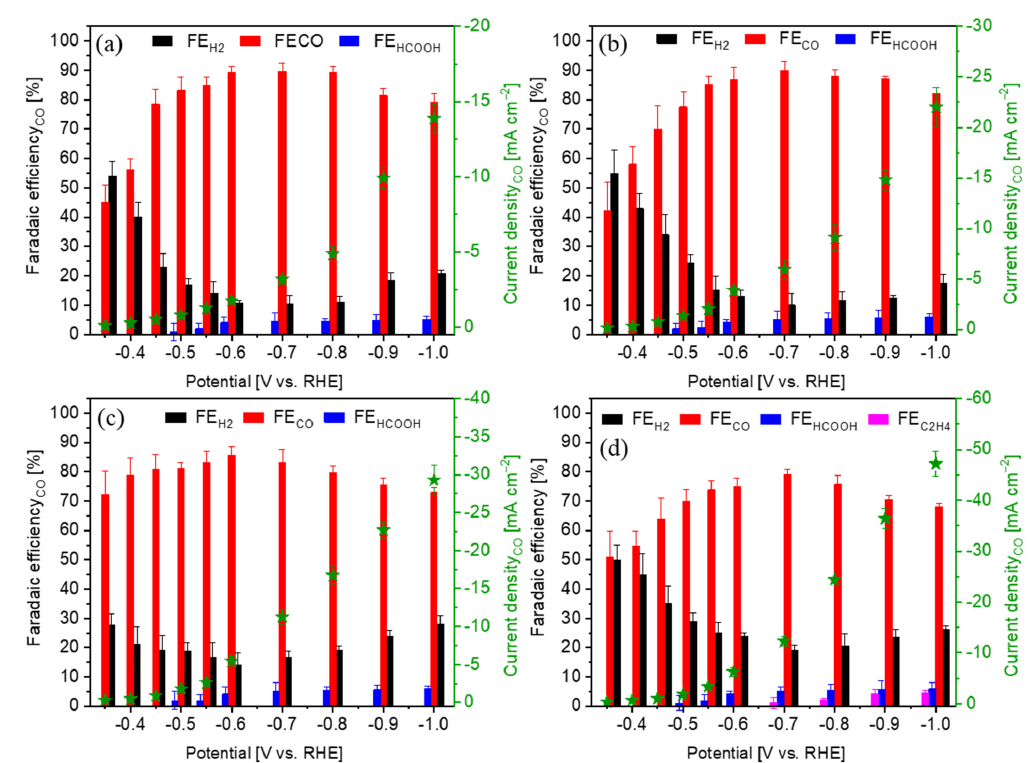
Figure 5. Product analyses and CO current density at a Sn-Cu 2 O electrode in a semi-flow cell with various CO 2 -saturated KHCO 3 electrolytes: ( a ) 0.1 M, ( b ) 0.5 M, ( c ) 1.0 M, and ( d ) 2.0 M.